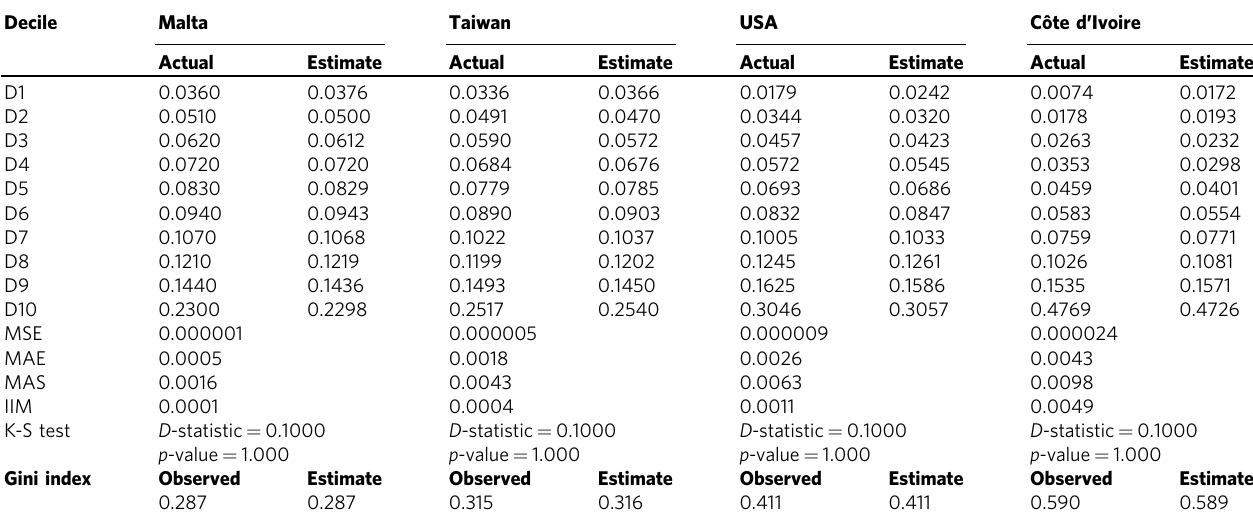
Table 6 The comparison between the actual and the estimated income shares by decile as well as the comparison between the observed and the estimated Gini index calculated using the error minimization method that utilizes all available grouped data on decile income shares as published in the